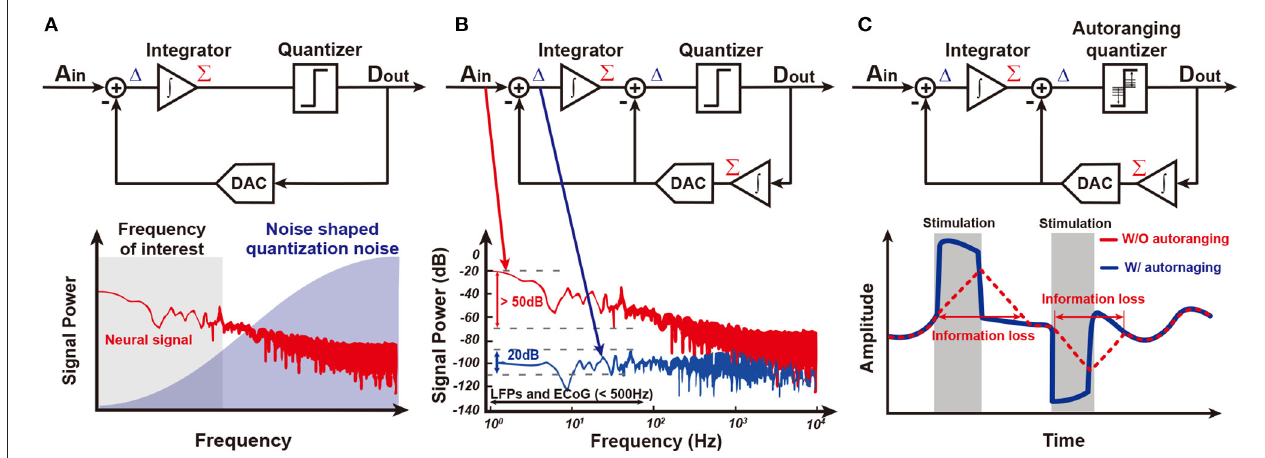
FIGURE 9 | Several 16 structure. (A) 16 shapes quantization noise into high frequency. (B) An integrator in feedback path of 16 ADC reduces the required input integrator’s dynamic range. This structure is called 1 2 6 ADC ( Kassiri et al., 2017). (C) An auto-ranging quantizer in 1 2 6 makes it possible to follow sudden changes in the input signal (Kim et al.,